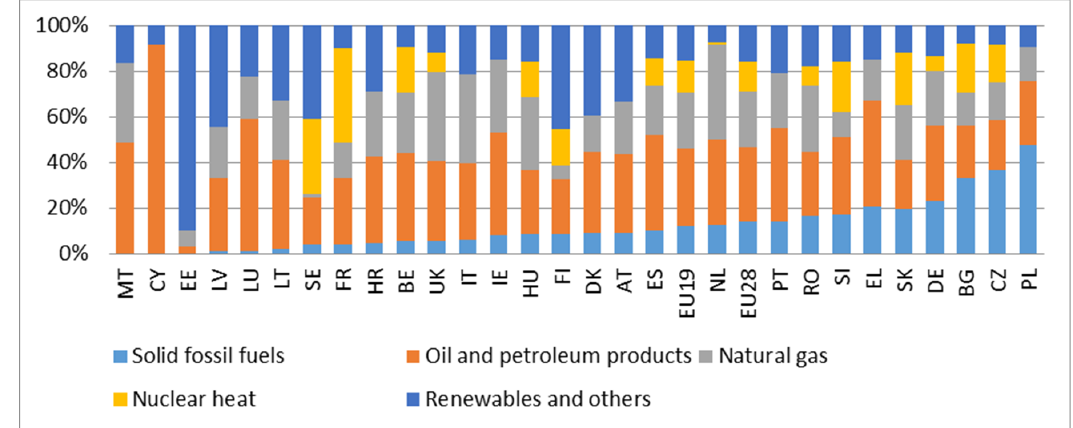
Figure 2. Total energy supply by product in 2017 (in %). Source: Authors’ calculations based on [10].